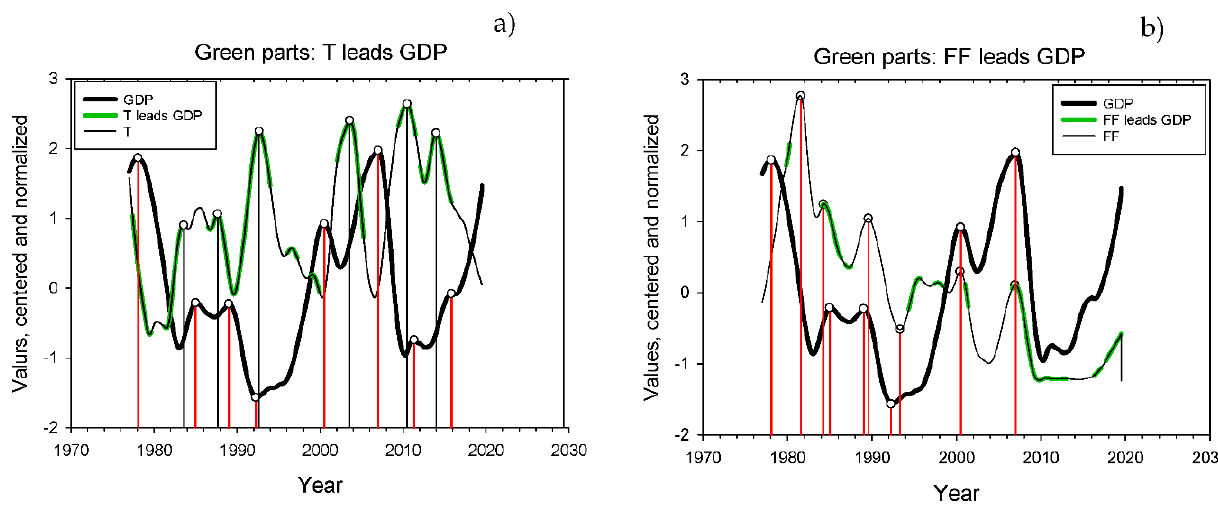
Figure 1. The Federal funds interest rate, FF, the Yield curve, T, and GDP. ( a ) Green portions of the curve, T, shows where T leads GDP. ( b ) Green portions of the curve, FF, shows where FF leads GDP. The drop-down lines allow a comparison of peaks and troughs in the two time series. Peaks and troughs are identified from the numerical time series.